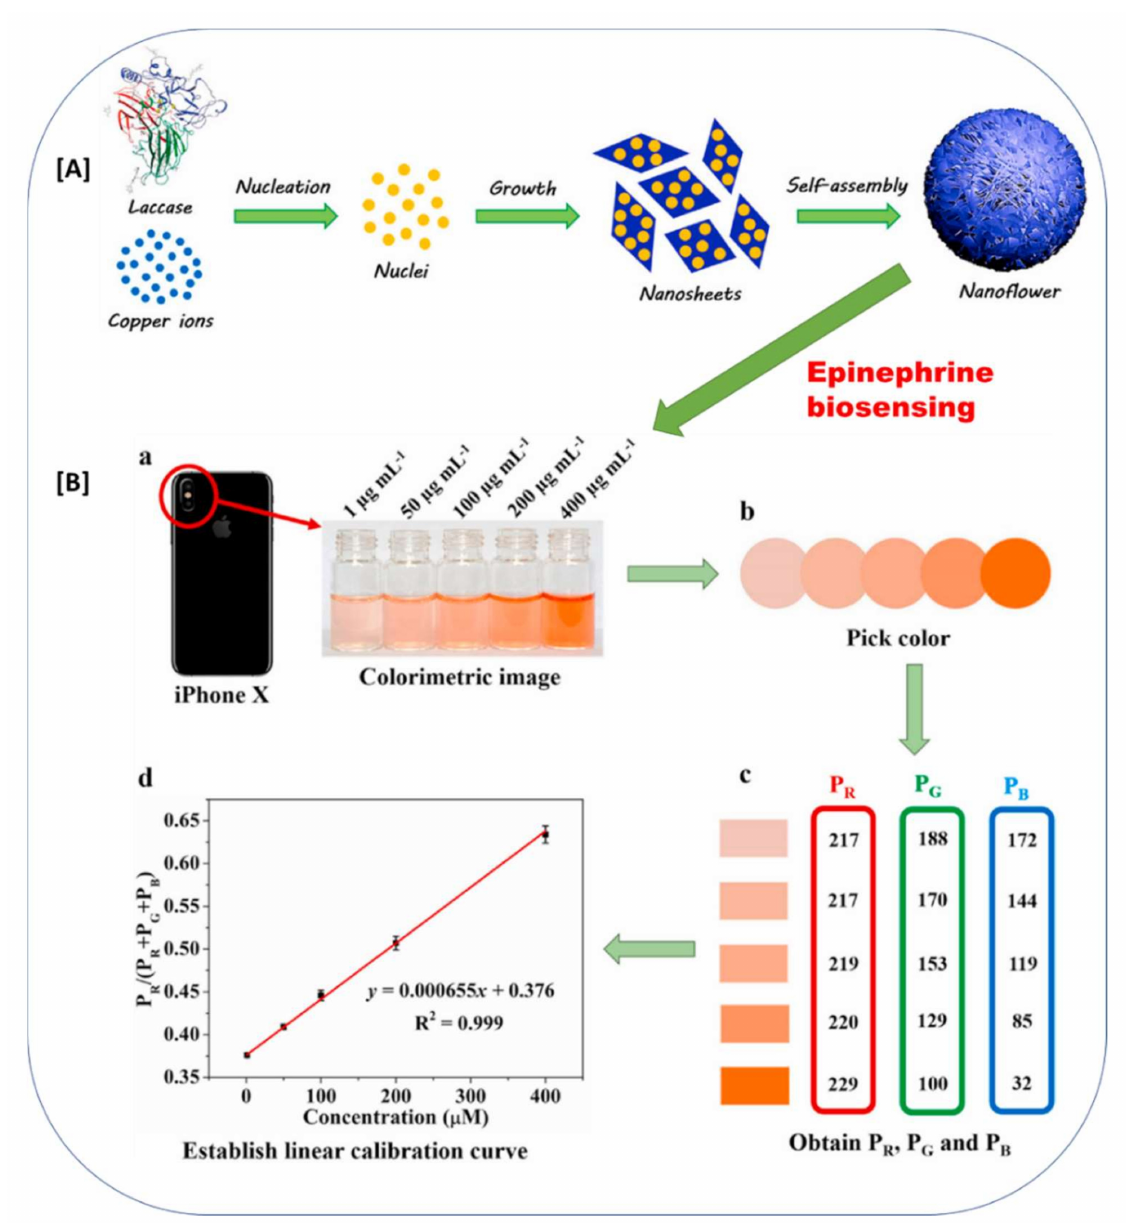
Figure 6. The biomineralization approach for laccase immobilizations in biosensing of the epinephrine. ( A ) Schematic representation of the formation of laccase-mineral (Cu 3 (PO 4 ) 2 · 3H 2 O) hybrid microflowers, ( B ) Application of laccase-mineral (Cu 3 (PO 4 ) 2 · 3H 2 O) hybrid microflowers for epinephrine biosensing; ( a ) Colorimetric image captured by iPhone X camera; ( b ) pick color via ColorPicker app; ( c ) obtain PR, PG, and PB; ( d ) establish a linear calibration curve. (The image ( A ) and ( B ) and respective figure captions were adapted from the Zhang et al., 2021 [56] with permission from Elsevier, Amsterdam, The Netherlands (License number: